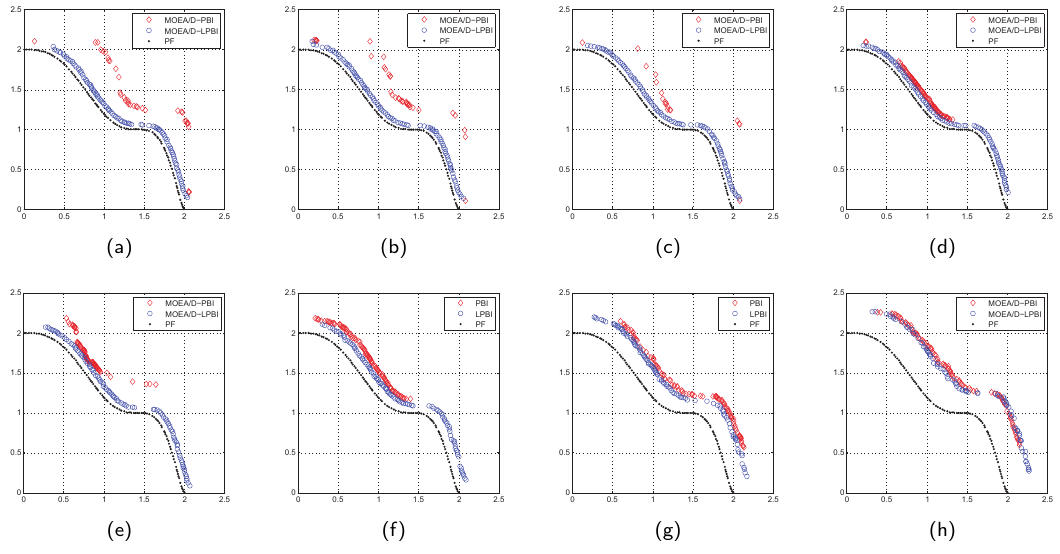
Figure A1. The approximation of Pareto front (PF) under different penalty values for Walking Fish Group (WFG)45-2 (color online). ( a ) θ = 0; ( b ) θ = 0.05; ( c ) θ = 0.1; ( d ) θ = 0.5; ( e ) θ = 1; ( f ) θ = 5; ( g ) θ = 20; and ( h ) θ =